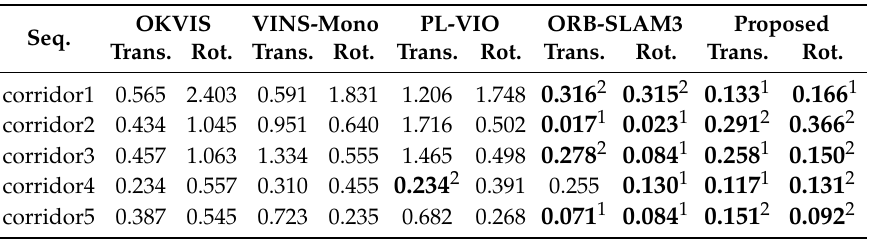
Table 2. The root mean square error (RMSE) of translation and rotation in the corridor sequences of the TUM-VI dataset. The results of the top 2 translation and rotation performances are represented in bold. OKVIS VINS-Mono Seq.